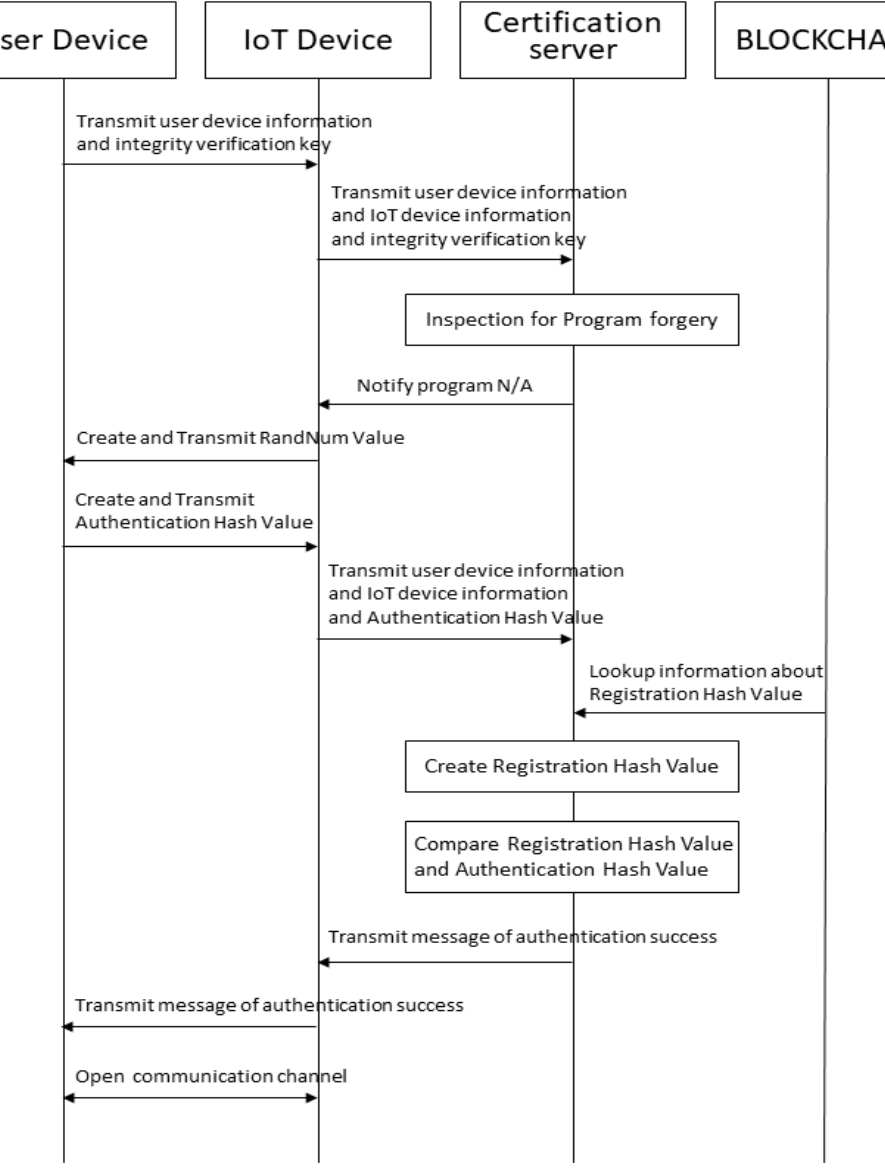
Figure 4. Multiple security certification system between IoT devices.